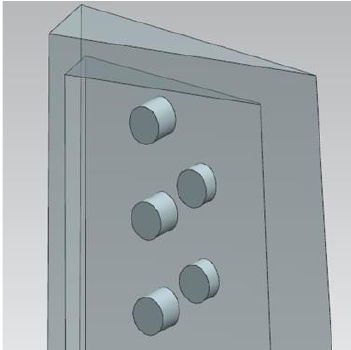
Figure 18. Schematic diagram of the cooling structure of the spoiler